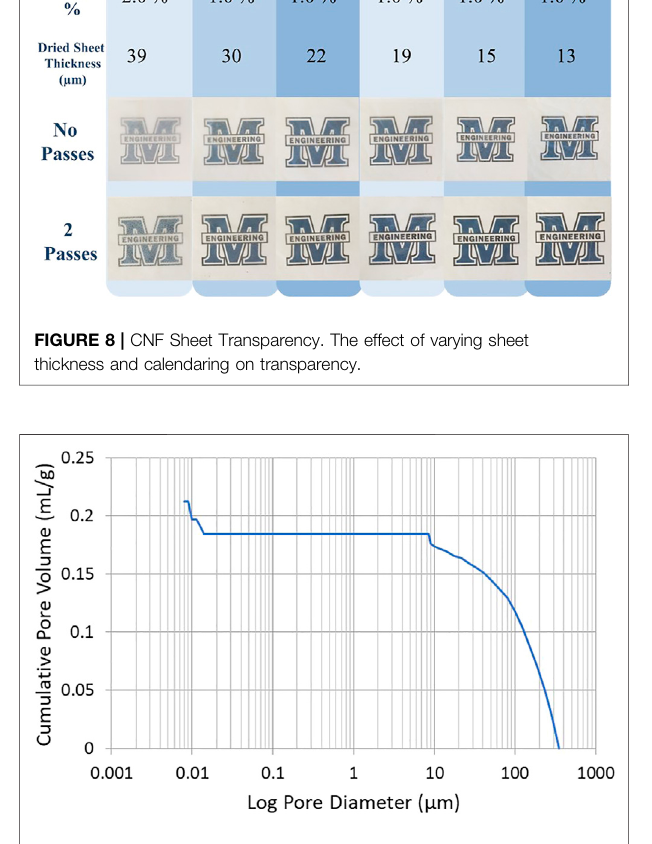
FIGURE 9 | Mercury Porosimetery Results. Pore volume analysis of a CNF